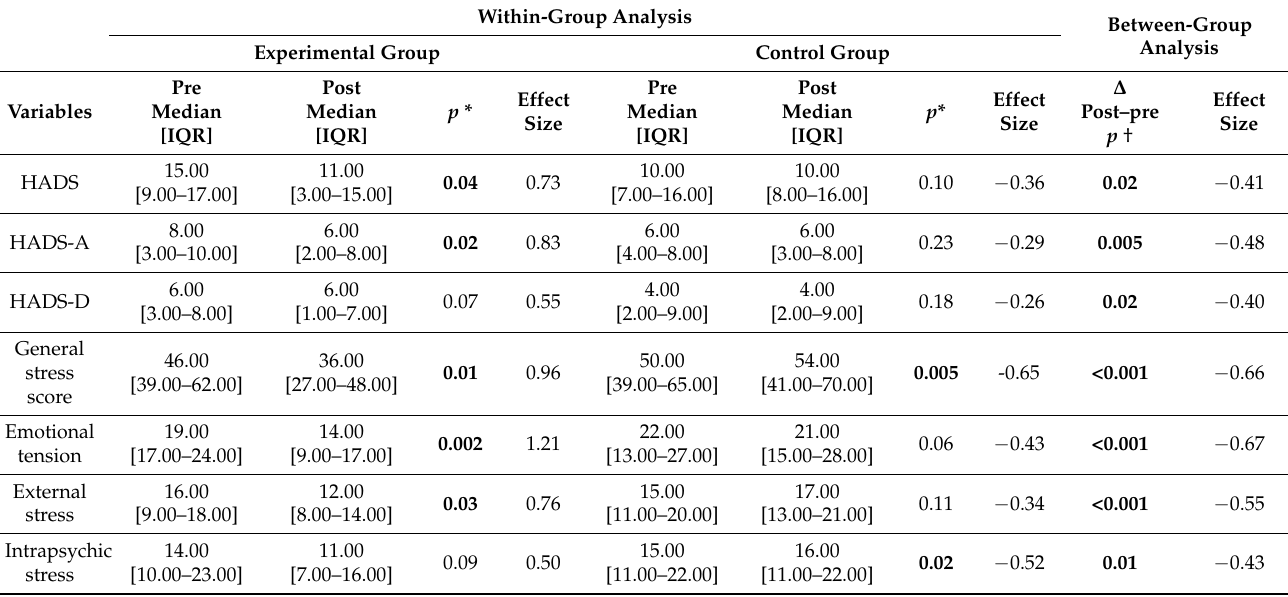
Figure 3. Between-groups analysis of the PSQ questionnaire scores in pre- and post-rehabilitation: ( a ) emotional tension; ( b ) external stress; ( c ) intrapsychic stress; and ( d ) total score. CG—control group; EG—experimental group; PSQ—Perception of Stress Questionnaire. Squares and circles show the mean, vertical lines show standard deviations, and slanted lines show the direction of between-group measurements change of the mean values. Table 3. The analysis of